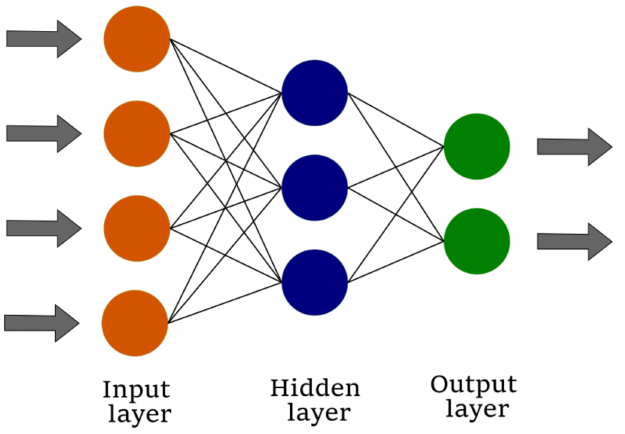
Figure 5. Simplified diagram of the neural